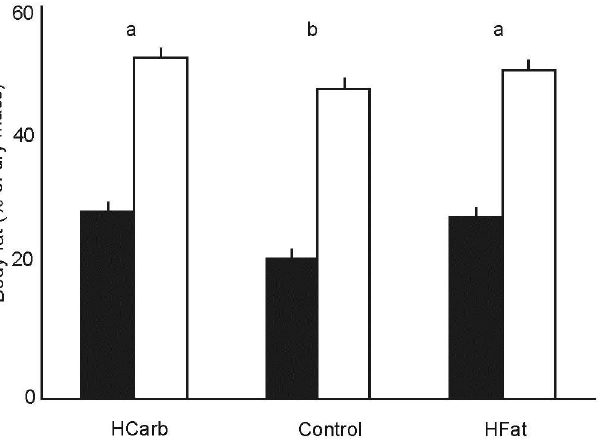
Fig 2. Dry mass body fat content (%) in H-BMR (black bars) and L-BMR (white bars) mice fed the HFat, HCarb and Control diet. Data presentedas least square means ± s.e.m. Different letters (a,b) show significantbetween-diet group